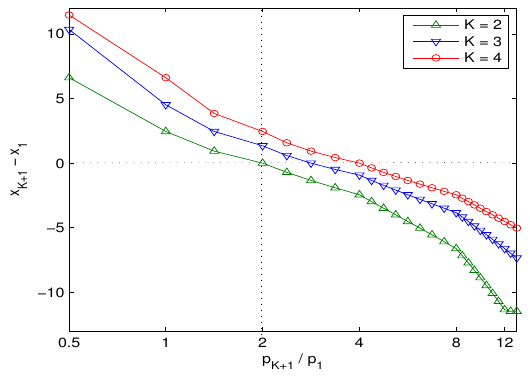
Figure 11. Optimal portfolio composition for Scenario A when the ratio of the unit price of the K -region secondary contract to that of the single-region secondary contract is